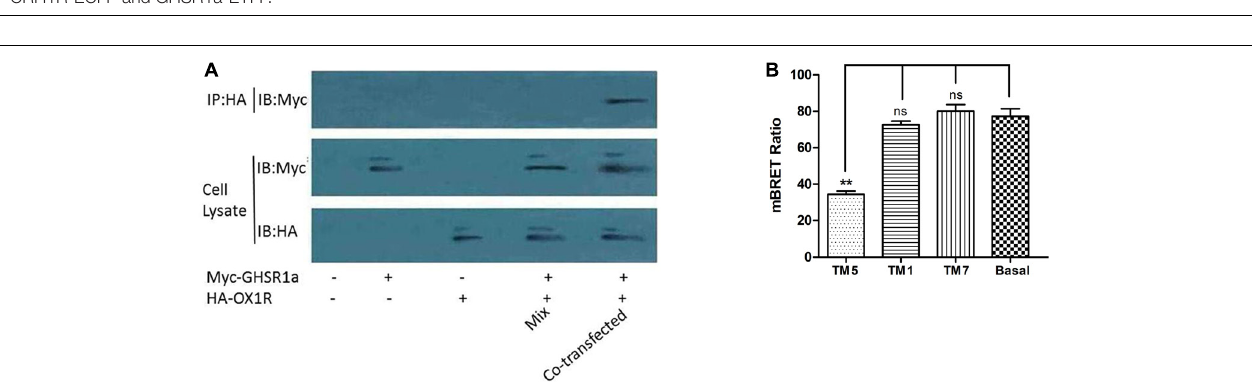
FIGURE 3 | Förster resonance energy transfer assay to detect the dimerization of GHSR1a/OX1R. (A) FRET imaging of constitutive GHSR1a/OX1R heteromeric interactions in living cells. HEK293 cells were transiently transfected with plasmids encoding (a) as a negative control group, CRH1R-ECFP and GHSR1a-EYFP. (b) GHSR1a-EYFP (acceptor), (c) OX1R-ECFP (donor), (d) OX1R-ECFP and GHSR1a-EYFP. Left panels, ECFP; center panels, EYFP; right panels, corrected FRET. (B) Normalized FRET values, calculated as described in Experimental Procedures. The data represent mean ± SEM ( N = 3) of four independent experiments. Statistical analysis was performed using one-way ANOVA followed by Tukey’s multiple comparison post hoc test. ∗∗∗ p < 0.001 vs. the negative groups CRH1R-ECFP and GHSR1a-EYFP.